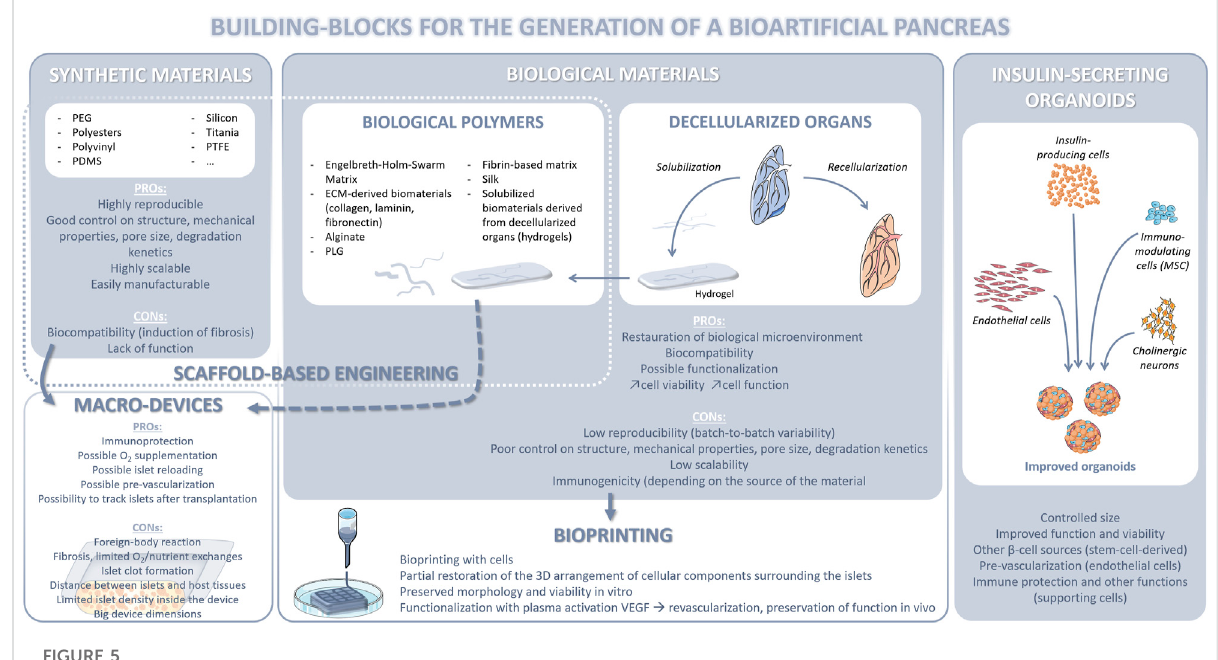
FIGURE 5 Regenerative medicine strategies applied to beta cell